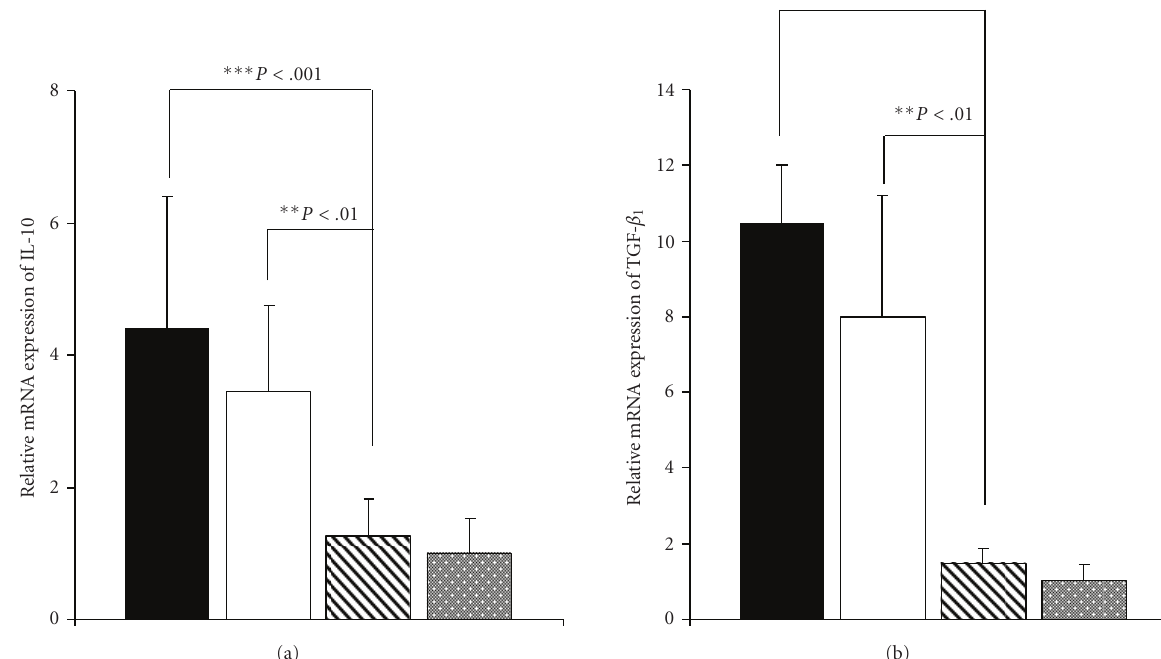
Figure 5: E ff ect of Plasmid with Gal-3 on Quantitative Expression of Cytokine Genes in lungs after Twelve Weeks of OVA Exposure. Relative mRNA levels of IL-10 (a) and TGF- β 1 (b) gene expression in lungs from di ff erent groups of mice were determined by real-time quantitative PCR. Values were normalized with the rRNA gene used as an endogen. Black bars represent the OVA group (geometric mean ± SD, n = 15), white bars the pEGFP group (geometric mean ± SD, n = 15), shaded bars the pEGFP-Gal-3 group (geometric mean ± SD, n = 20), and gray bars the SS group (geometric mean ± SD, n = 10). The results show relative gene expressions, as determined by the ΔΔ C T method, after twelve weeks of antigen exposure. Significant di ff erences in IL-10 and TGF- β 1 ( ∗∗∗ P < . 001) expression levels were obtained for the pEGFP-Gal-3 versus the OVA and pEGFP groups. In the case of empty plasmid, no significant di ff erences were found with respect to the OVA